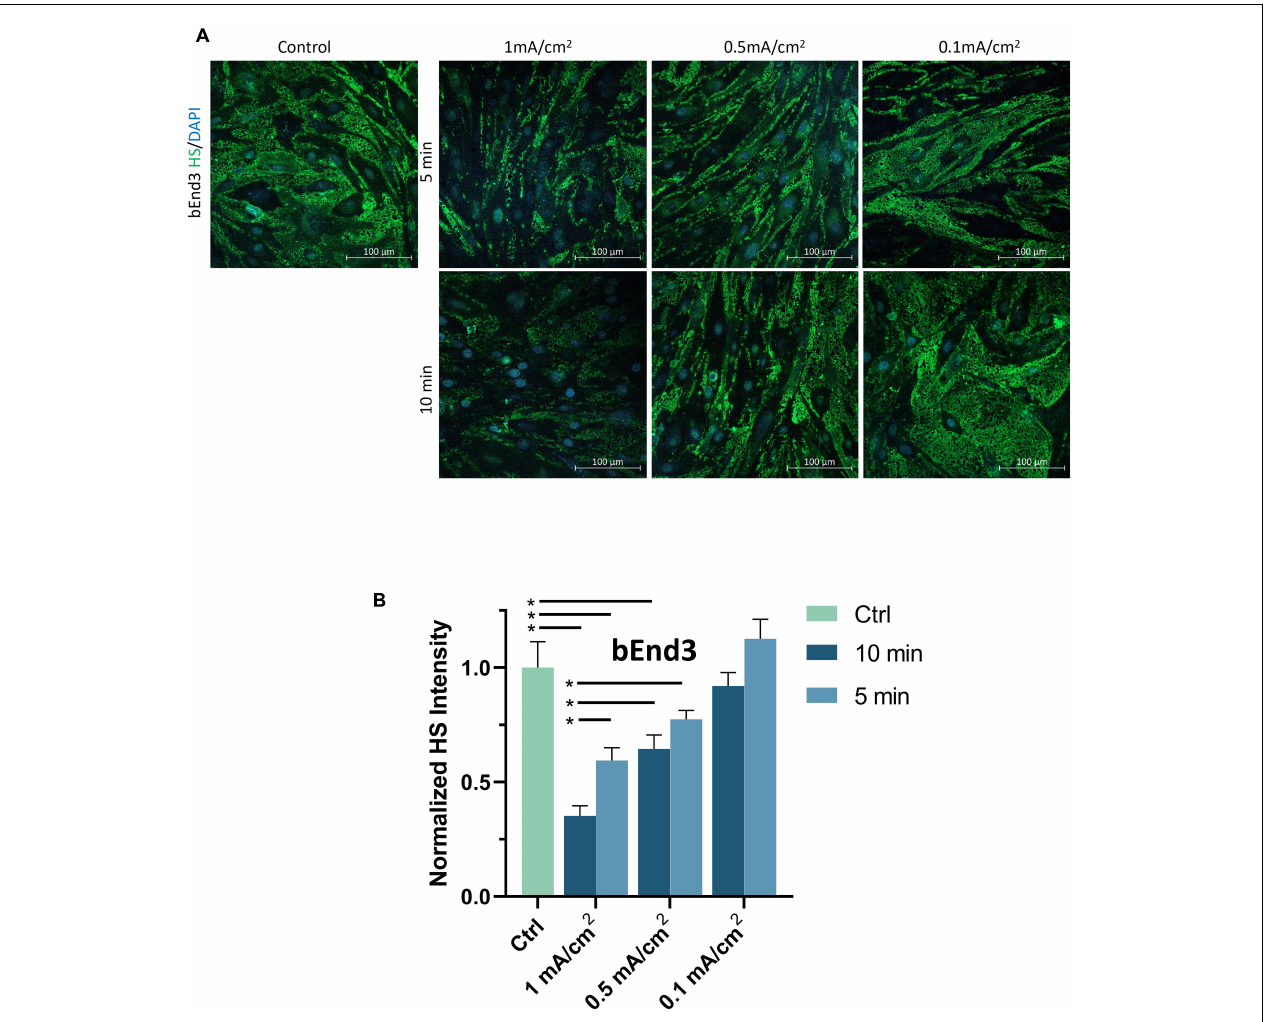
FIGURE 6 | Effects of DCS strength on HS of endothelial glycocalyx (EG) of in vitro BBB formed by bEnd3 monolayer. (A) Confocal images of heparan sulfate (HS) of EG on in vitro BBB and (B) comparison of HS intensity under control and after 5 min or 10 min treatments with 0.1, 0.5, or 1 mA/cm 2 DCS. * p <